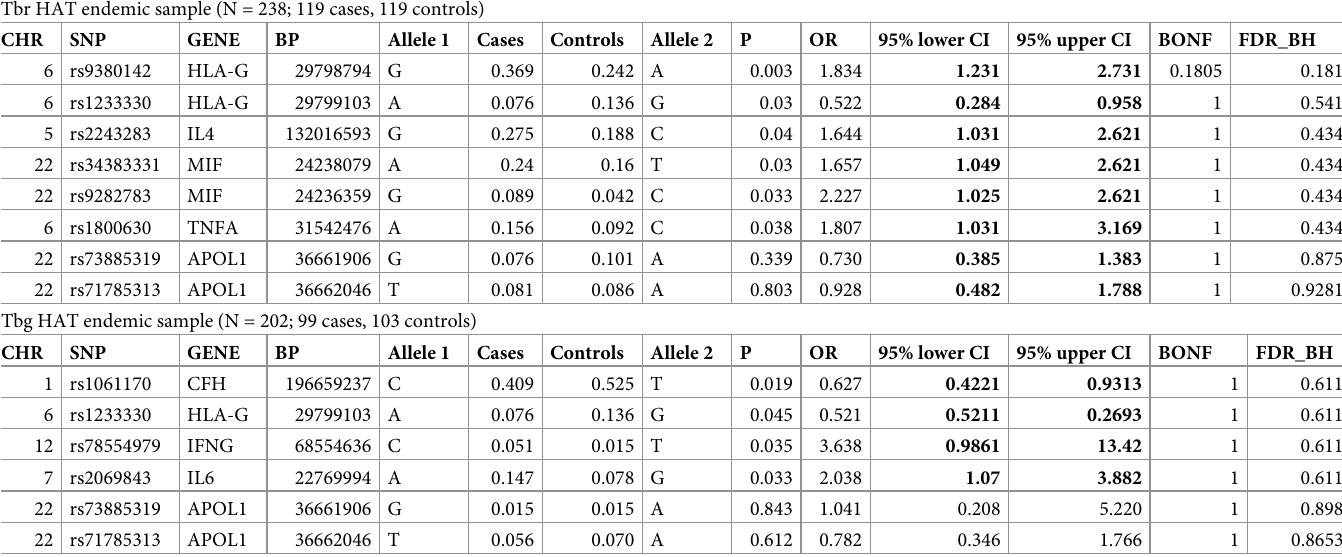
Table 1. SNPs that showed the lowest p values after association testing with Tbr and Tbg HAT. Tbr HAT endemic sample (N = 238; 119 cases, 119